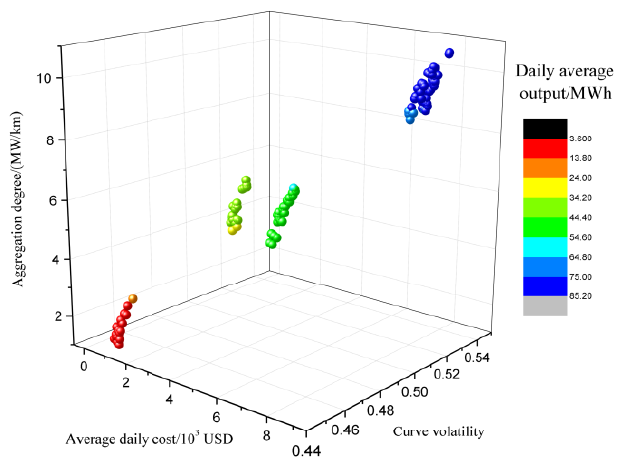
Figure 7. Pareto solution sets.